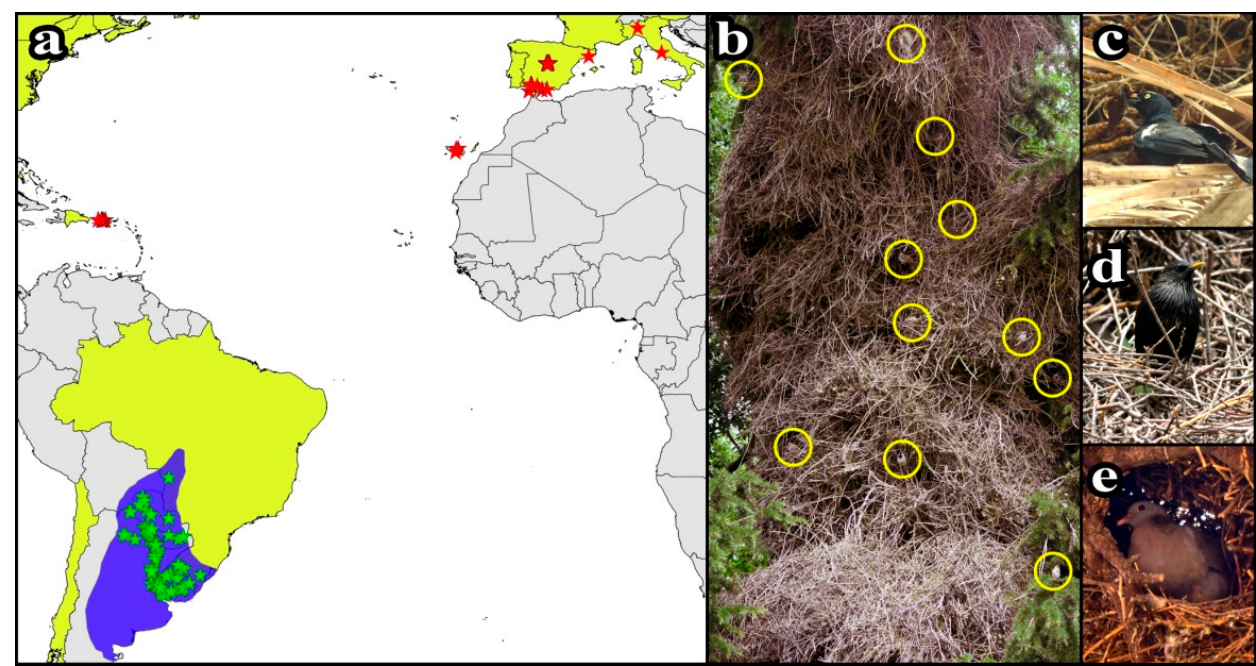
Figure 1. ( a ) Location of monk parakeet nests monitored in the native (blue area; green stars) and invaded (yellow area; red stars) ranges of the species. ( b ) Monk parakeet colony established in a rural area (Madrid, Spain) with tenant nests (yellow circles) of two sparrow species (house sparrow Passer domesticus and Eurasian tree sparrow P. montanus ). Different nesting strategies by tenant species: ( c ) greater Antillean grackle Quiscalus niger using monk parakeet nests as nesting substrate, ( d ) spotless starling Sturnus unicolor nesting in openings from external stick conglomerate, and ( e ) stock dove Columba oenas occupying chambers built by monk parakeets. Photos: Dailos Hernández-Brito.